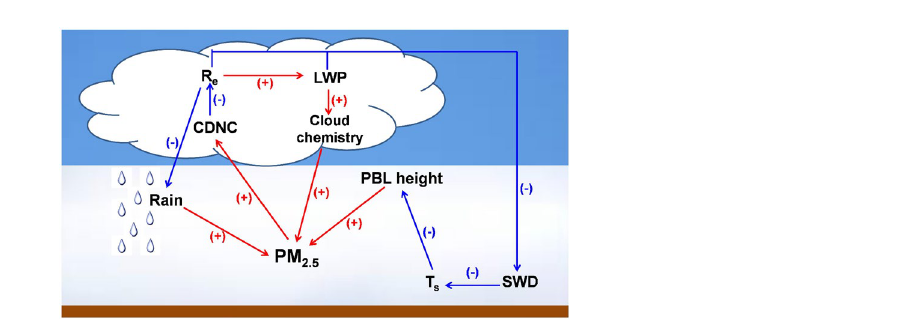
Figure 4. Schematic diagram for the “self-enhancement” of PM 2.5 due to aerosol-cloud interactions. The ( + )/( − ) in the figure means an increase in PM 2.5 would lead to an increase/decrease in a certain variable. R e represents cloud droplet effective